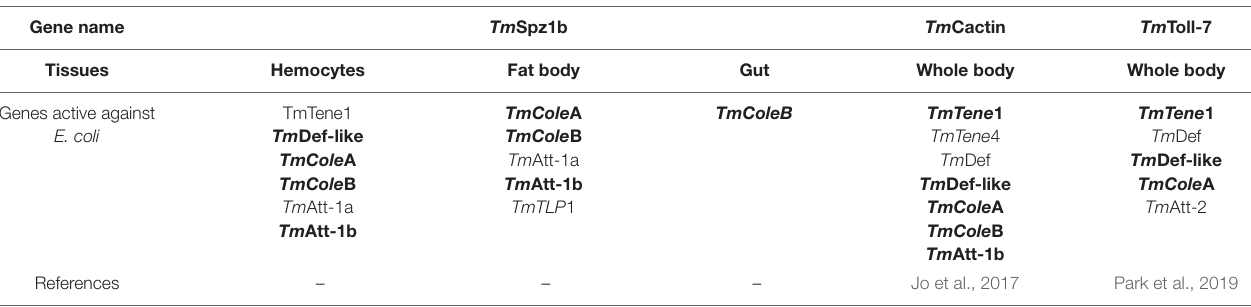
FIGURE 10 | Proposed immunological function of Tm Spz1b in innate immune response to microbial challenges. The immunological functions of Tm Spz1b against E. coli (A) , S. aureus, and C. albicans (B) are separately proposed. (A) Tm Spz1b influences the transcriptional regulation of seven and five AMP genes in hemocytes and fat body of T. molitor larvae in killing the Gram-negative pathogen E. coli. (B) Tm Spz1b does not affect the resistance to Gram-positive and fungal infections in T. molitor larvae due to non-regulation of AMP genes. TABLE 2 | Important AMP genes predicted by our recent